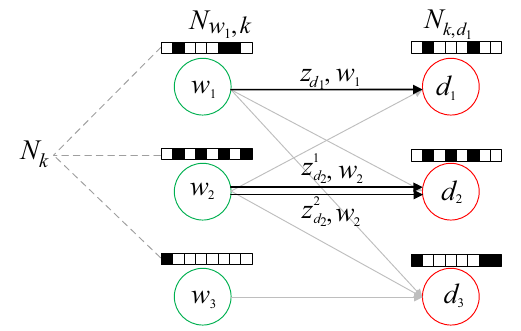
Fig. 1 Graph-based data and model